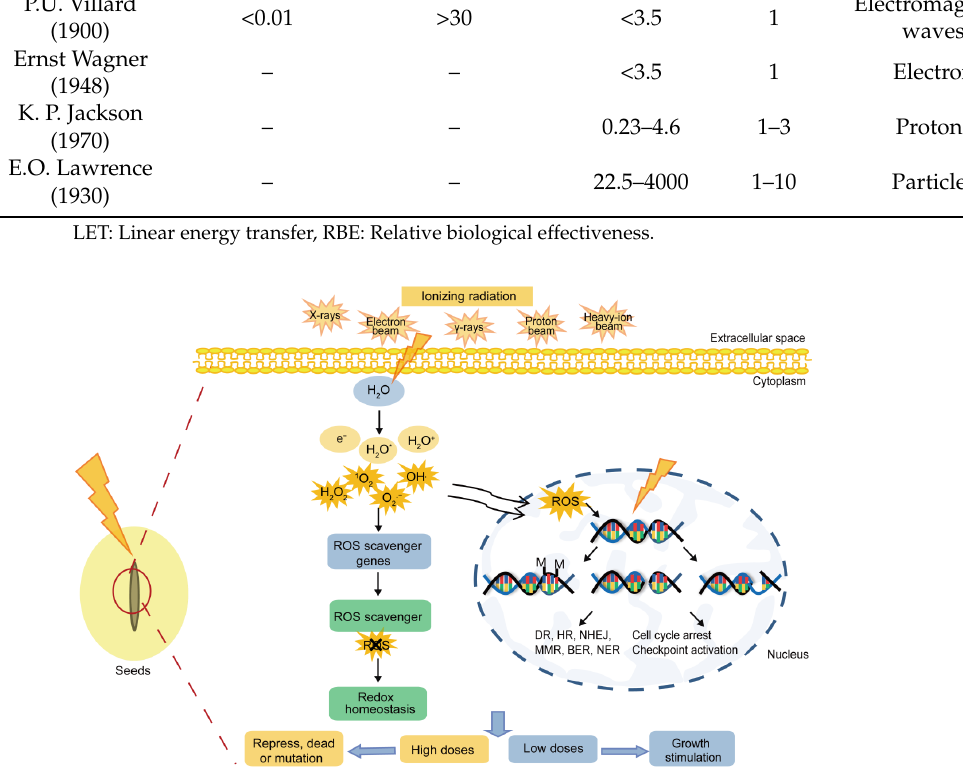
Figure 3. Schematic diagram of ionizing radiation acting on the organism. They can direct break the chemical bonds between atoms or molecules on the DNA molecule, causing the DNA single- or double-strand break, base deletion, or DNA methylation, and this can trigger cell cycle arrest and checkpoint activation, but most of the damage can be repaired correctly by direct repair (DR), ho- mologous recombination (HR), non-homologous end joining (NHEJ), mismatch repair (MMR), base-excision repair (BER), or nucleotide excision repair (NER) mechanisms. However, the repair of the errors sometimes will be reserved and lead to chromosomal aberrations and genetic mutations. Further, in the way of the indirect actions, reactive oxygen species (ROS), namely, some strong oxidants and highly reactive free radicals, were also generated by water radiolysis, including short- life species, such as superoxide anion radical (О 2• − ), hydroxyl radical (ОН • ), singlet oxygen ( 1 О 2 ), and long-life species, such as hydrogen peroxide (Н 2 О 2 ), etc. These free radicals induced “oxidative stress” in cells, including lipid peroxidation and the oxidative modification of the pro- teins and nucleic acids, meanwhile, the content of antioxidants are also increased to regulate redox homeostasis. Excited water molecule (H 2 O*). Methylation (M). Figure 4. X- ray and γ -ray, electron beams, proton ions, and heavy-ion beams of physical agents used for seed priming and their mode of action.